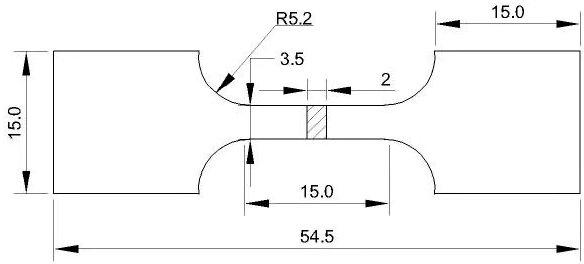
Figure 2. Drawing of tensile sample (unit: mm) .